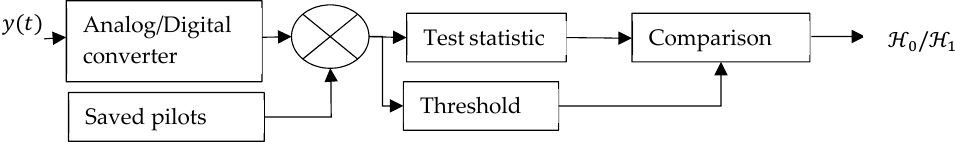
Figure 4. Block diagram of matched filter based spectrum sensing.